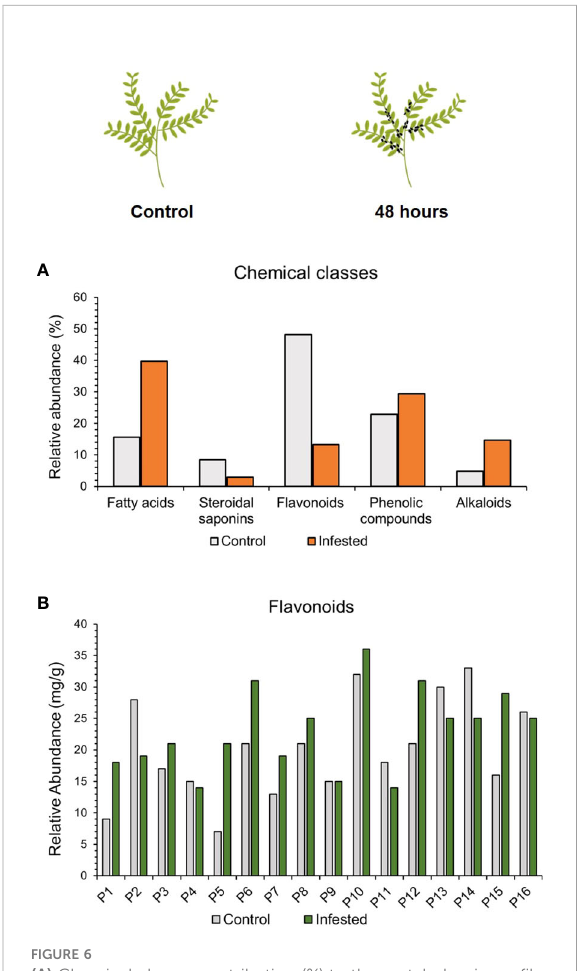
FIGURE 6 (A) Chemical classes contribution (%) to the metabolomic pro fi le of lentil accessions and (B) semi-quanti fi cation of fl avonoids (mg/g of dry weight) after 48h of aphid